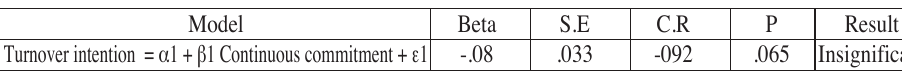
Continuous Commitment and Turnover Intention